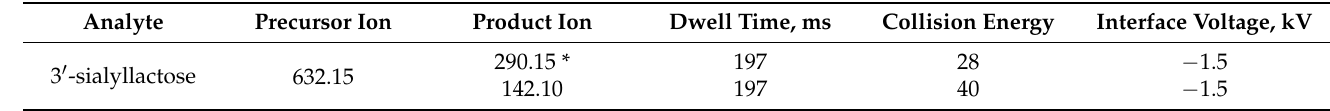
Figure 2. Product-ion scan spectra of 3’-sialyllactose. Table 2. Multi-reaction monitoring ion pairs and mass spectrometry